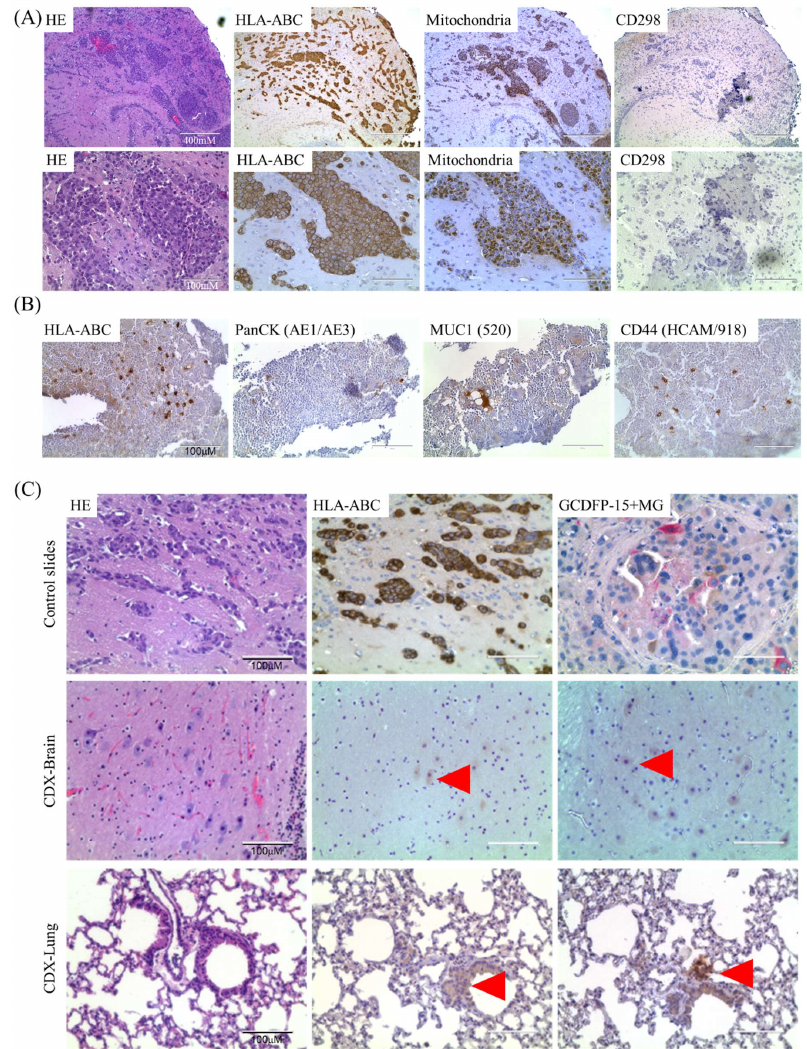
Figure 3. HLA-ABC identifies cells of human origin in xenografted mice. ( A ) Serial sections of brain macro-metastasis obtained 6 weeks after intracardiac injection of 1 × 10 5 MDA-MB-231BR cells. Left to right: Hematoxylin-eosin (HE) staining, HLA-ABC, anti-mitochondrial antibody, CD298 staining. Upper panels show lower magnification, and lower panels show higher magnification imaged. Note that both HLA-ABC and the anti-mitochondrial antibody identify the same malignant lesions identified in the HE stained section. CD298 did not identify the metastatic masses. Also note the localization of HLA-ABC staining in the cell membrane while the anti-mitochondrial antibody localized to the cytoplasm. ( B ) Serial sections of mouse bone marrow 3 weeks after intra-cardiac injection of 1 × 10 5 MCF10A cells. Left to right: HLA-ABC, PanCK, Mucin1, CD44 IHC. Note HLA-ABC identifies both PanCK + as well as CD44 + cells. ( C ) CTC-derived xenograft (CDX) brain and lung tissues show solitary CTC-derived cells as micro-metastatic seeding. Top panels show staining patterns in positive control slides. Left: HE, center: HLA-ABC, right: GCDFP-15 + MG. MDA-MB-231BR-derived brain metastatic lesion used a positive control for HE and HLA-ABC staining. HER2 + PDX mouse brain tissue was used as positive control for GCDFP15 / MG staining. GCDFP-15 + MG shows brown (HRP-DAB) staining for mouse antibody clones 23A3 (anti-GCDFP-15) and 304-1A5 (anti-MG), and red (AP-Red) staining for rabbit clone 31A5 (anti-MG). Middle and bottom panels show serial sections of CDX-Brain and CDX-Lung tissues stained for HE, HLA-ABC, or GCDFP-15 + MG IHC, respectively. Red arrowheads indicate positive staining using either HLA-ABC or GCDFP-15 + MG, showing solitary mBC CTC-derived cells in brain and lung micro-metastases (scale bars = 100 µ